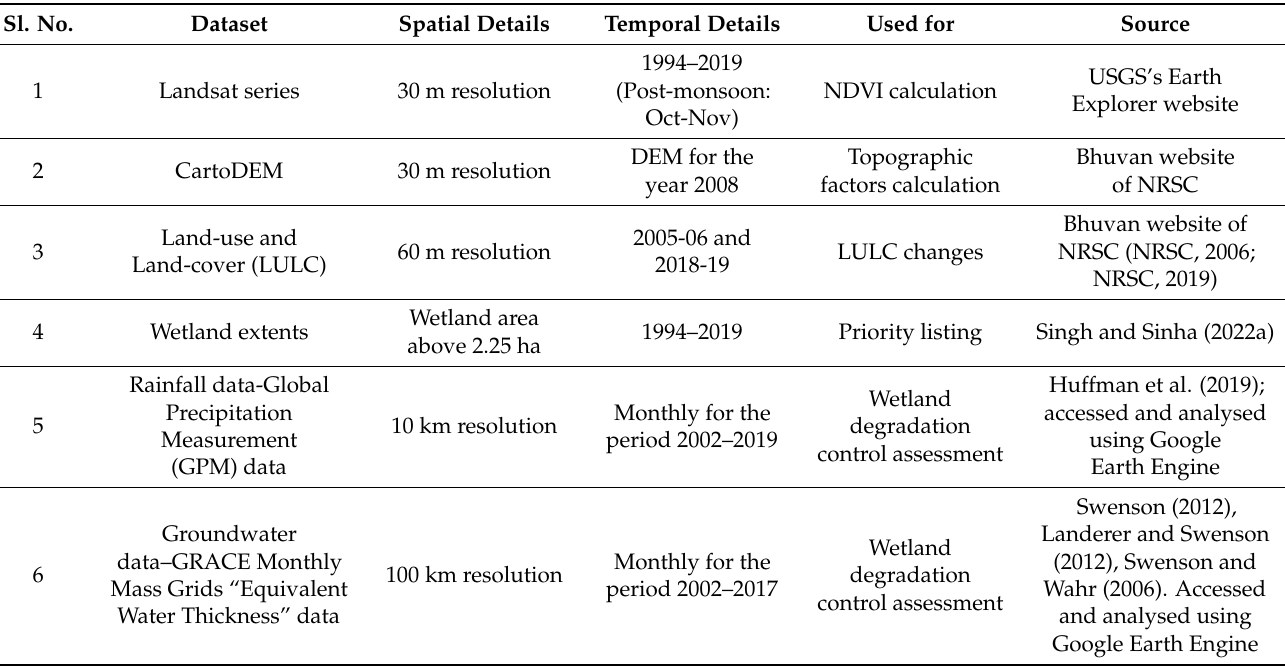
Table 1. Details of the datasets used in the present